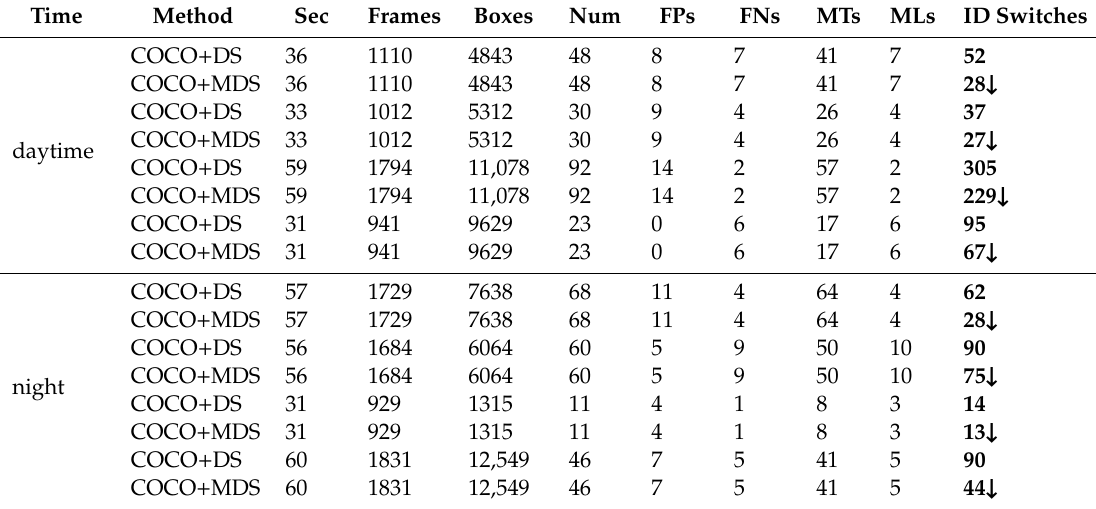
Table 3. Samples of vehicle tracking using the MDS and DS algorithms with a detection model trained on the COCO